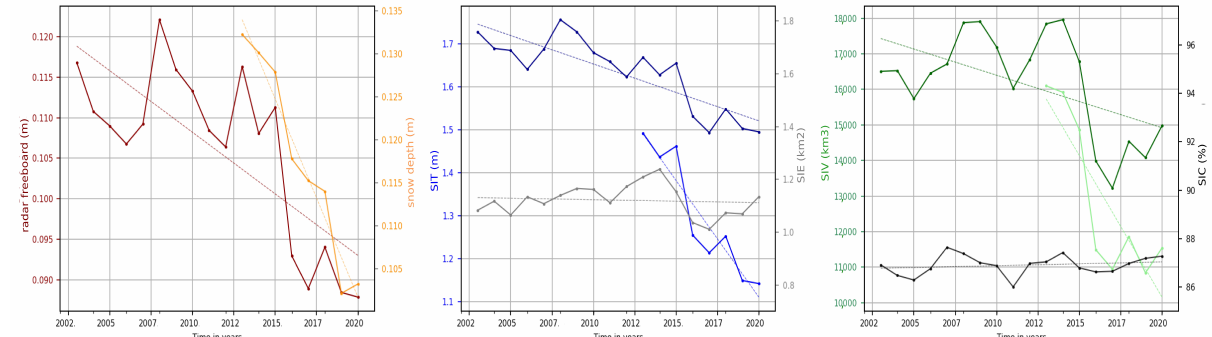
Figure 9. 2003–2020 time series of radar freeboard (in red), snow depth (in orange), sea ice thickness (in blue) and volume (in green) for sea ice concentration higher than 75%. The NSIDC sea ice extent (in grey) and concentrations (in black) are also represented. The radar freeboards are those of the CS2-TFMRA50 dataset. All 2013–2020 series are computed using the ASD snow depth while the 2003–2020 series use the AMSR-clim. Trends, with values indicated in Table A1, are also indicated in dotted